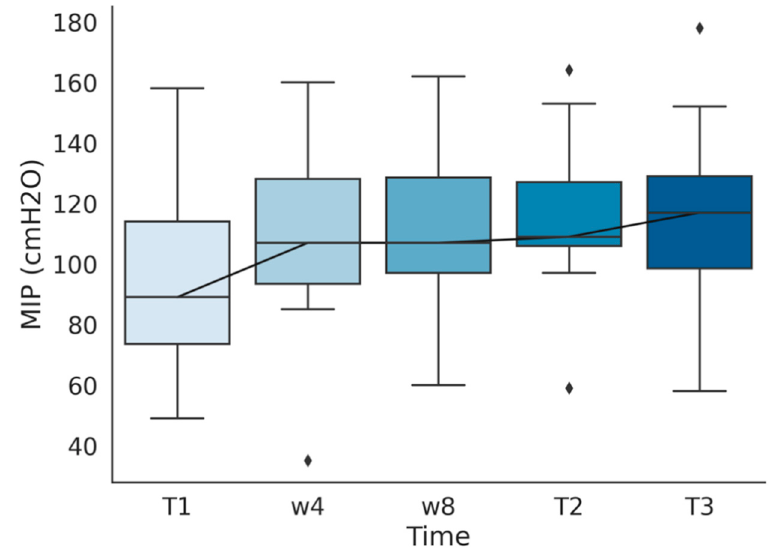
Figure 1. Maximum Static Inspiratory Pressure (MIP) measured before training (T1), after the first (w4) and second (w8) month of training, at the end of the program (T2), and in a six months follow-up after finishing the program (T3).